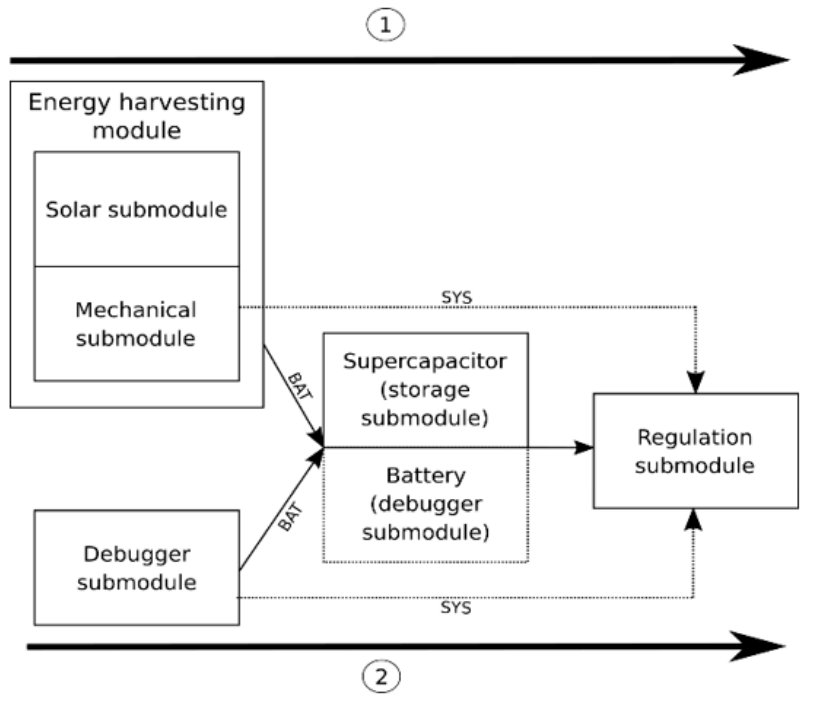
Figure 2. Power module architecture. Path 1 gets energy from the two energy harvesting modules (solar and mechanical) to charge the supercapacitor and the battery (if connected) to power the regulation module. In this path, the debugger (USB) is not connected and, usually, neither is the battery. Path 2 gets energy from the debugger module to charge the supercapacitor and the battery (if connected) to feed the regulation module. In this path, the debugger is connected and the battery is not usually plugged in. The USB and battery are only connected for debugging cases.